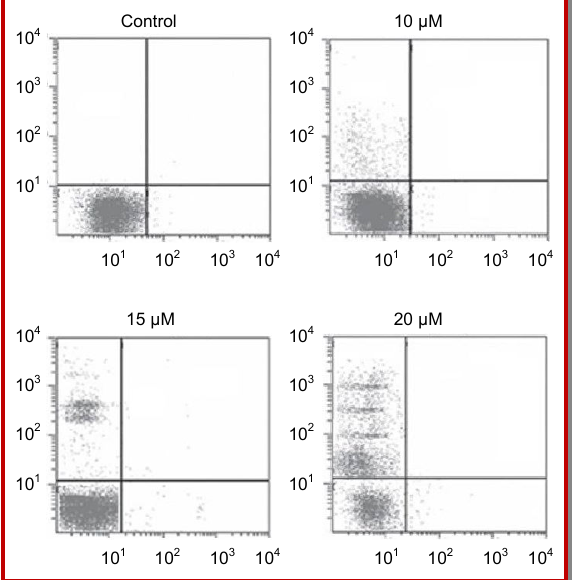
Figure 2: Zerumbone induced cell death in DU-145 prostate carcinoma cells. The cells were incubated with various doses of